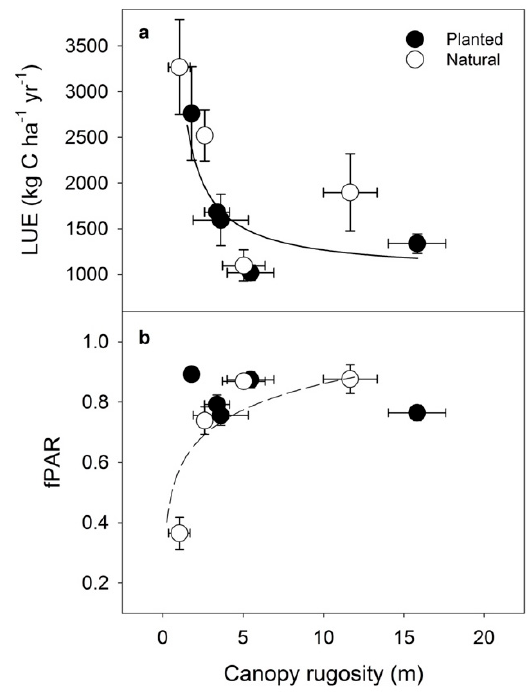
Figure 5. Mean light-use efficiency (LUE) ( a ) and absorbed fraction of photosynthetically active radiation (fPAR); ( b ) (± SE, n = 3) in relation to mean canopy rugosity (± SE, n = 3) in planted pine and natural pine stands. Solid and dashed lines represent significant ( P < 0.05) change with age in the planted and natural chronosequences, respectively (a, r 2 = 0.46; b, r 2 = 0.49).